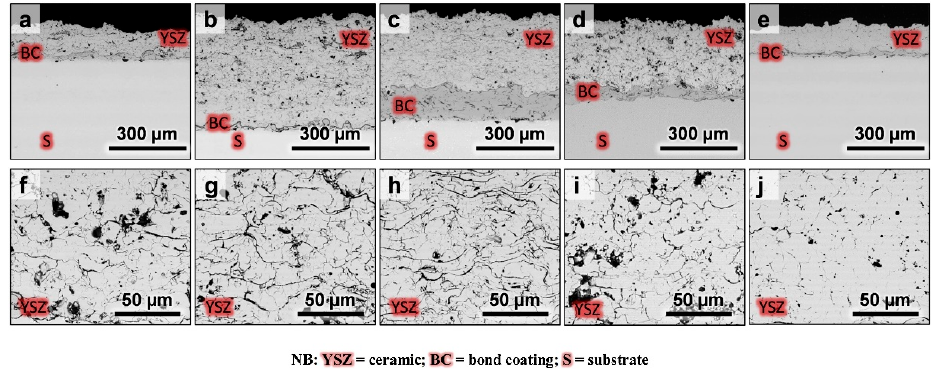
Figure 12. SEM micrographs of cross-sections of TBCs with different parameters: ( a ) AM1-APS 1: Haynes 188 + 40 µ m NiCrAlY + 110 µ m YSZ, ( b ) AM1-APS 2: Haynes 188 + 15 µ m NiCrAlY + 430 µ m YSZ, ( c ) DFL-APS:Haynes 188 + 130 µ m NiCoCrAlY + 330 µ m YSZ, ( d ) In-APS: Inconel 600 + 72 µ m NiCrAlY + 230 µ m YSZ, ( e ) AM1-APSmf: Haynes 188 + 15 µ m NiCrAlY + 90 µ m YSZ, and ( f – j ) are the corresponding higher magnifications of the ceramic coatings